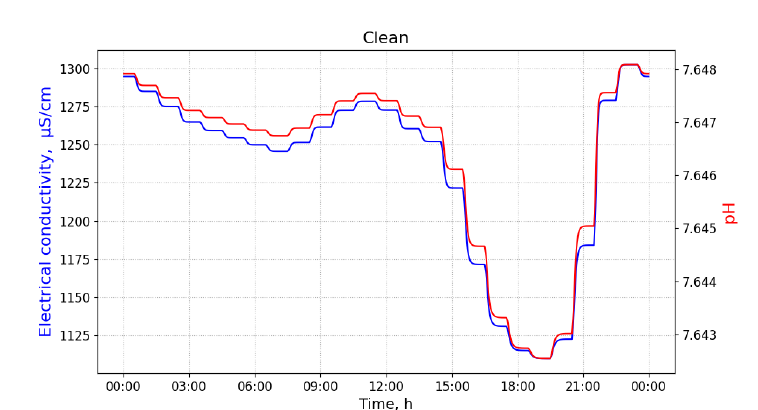
Figure 3. Measurements of pH and electrical conductivity for the clean utility network content. Values of the horizontal axis represent time of the day. Measured at the manhole